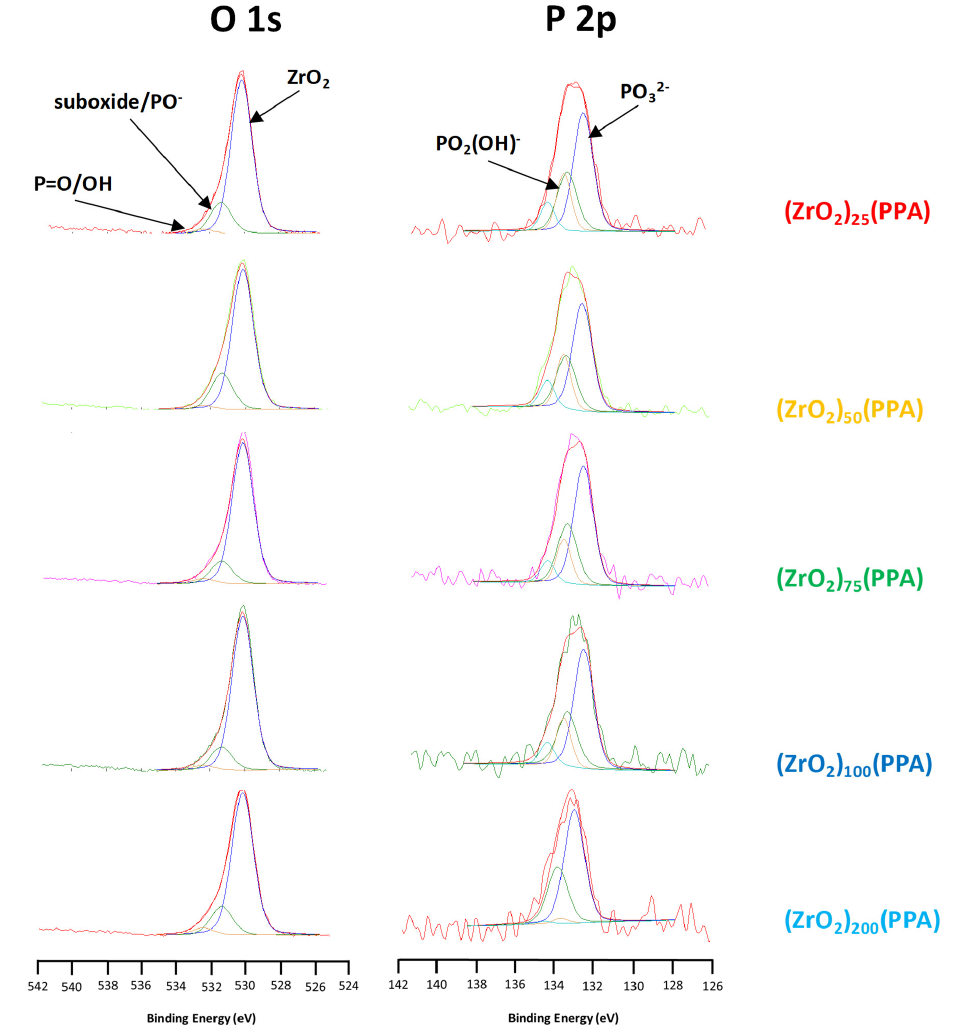
Figure A4. X-Ray Photoelectron Spectroscopy study of (ZrO 2 ) x (PAA) Samples (Zr/P ratio ( x ) = 25, 50, 100, 200).